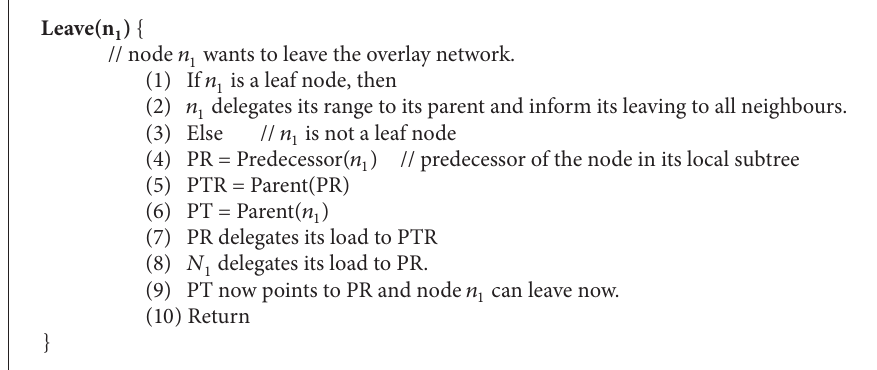
Algorithm 4: Peer leave mechanism of proposed